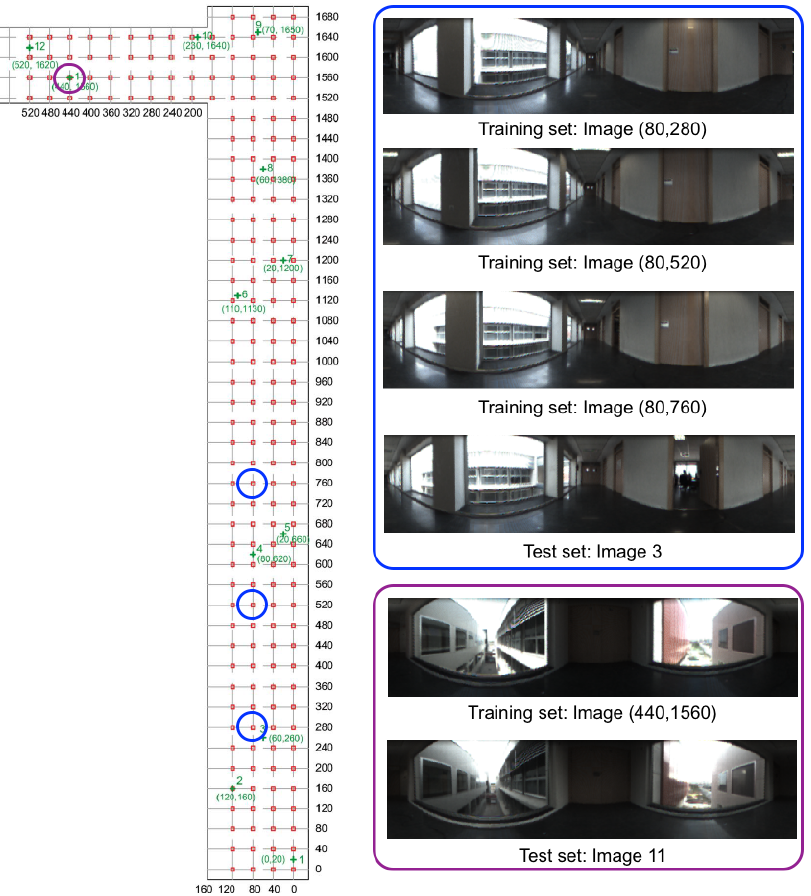
Figure 4. Corridor. Bird’s eye view of the capture points of the training set of images. The size of the grid is 40 × 40